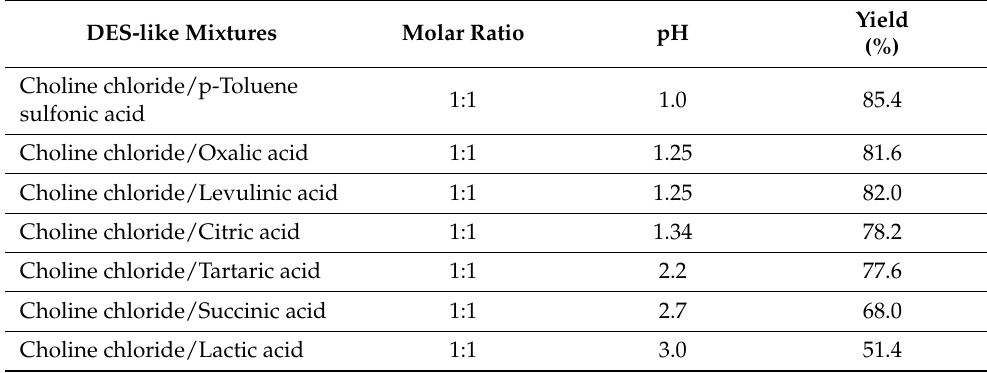
Table 2. Valorization of hemicelluloses and furfural yield using different DES-like mixtures * (adapted according to Arrora et al.)